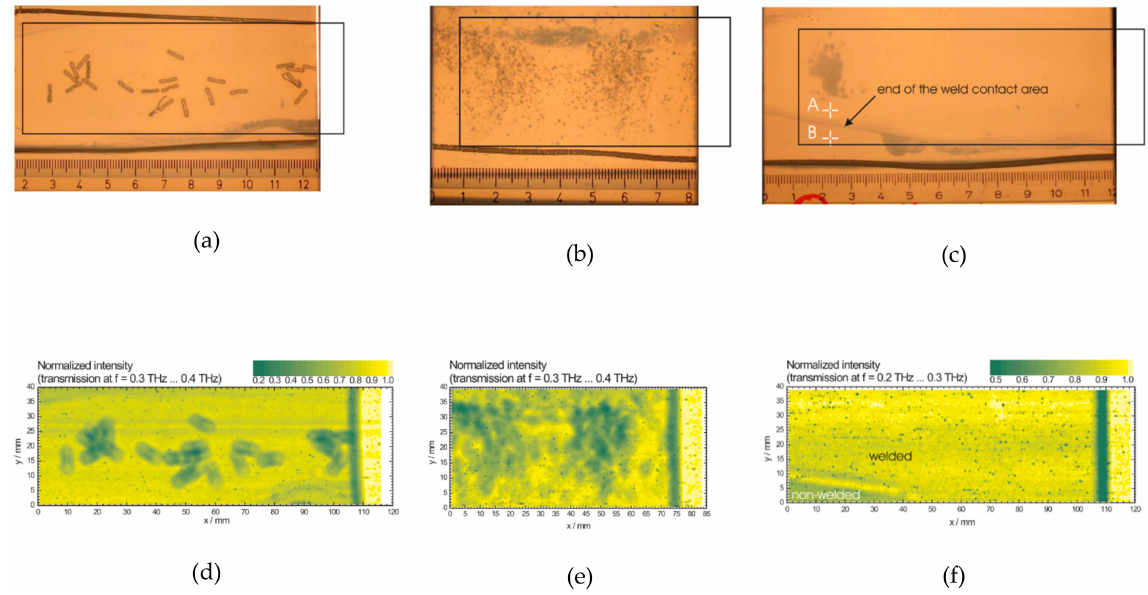
Figure 4. THz TDS transmission imaging of foreign objects between HDPE laminates: ( a – c ) Backlighted photograph of metal staples, sand, and air between welded HDPE laminates, respectively; ( d – f ) TDS imaging of the same sample above. Foreign objects and air can be seen as areas with low transmitted intensity [48].